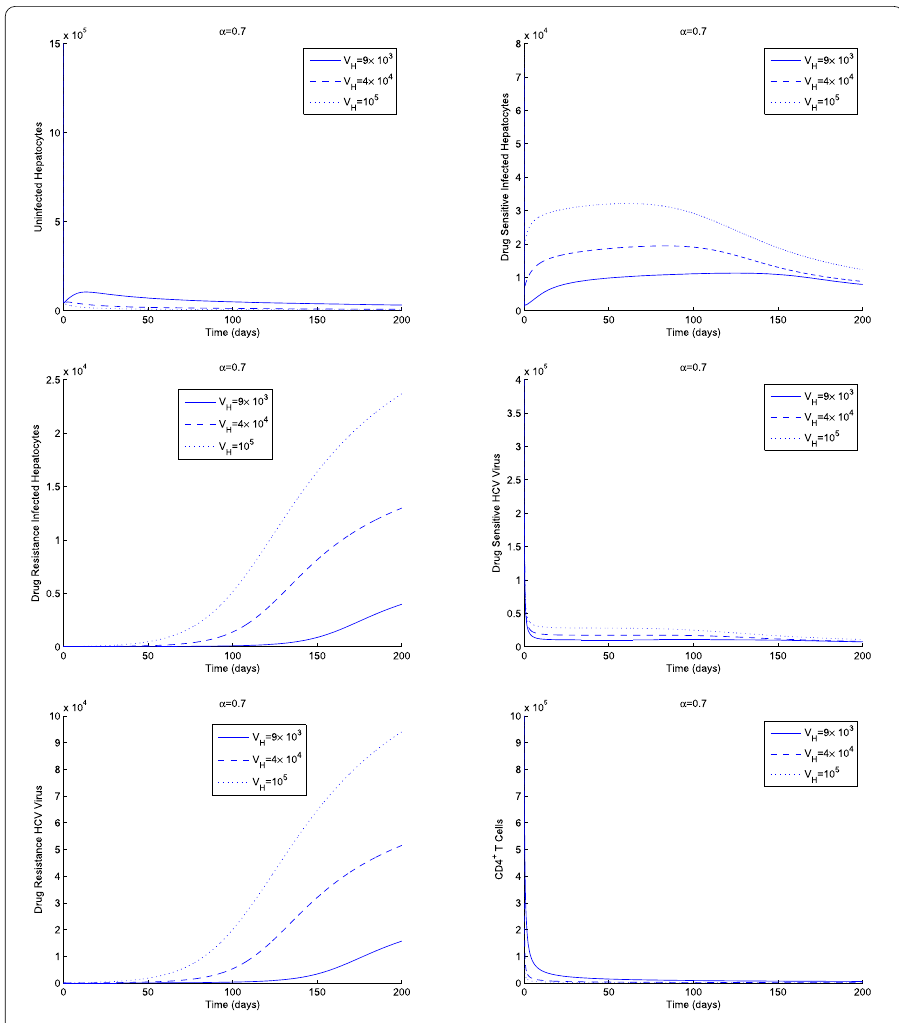
Figure 4 Dynamics of the variables of system (1) for different values of V H , the HIV viral load, and α = 0.7. Parameter values are in Table 1 and initial conditions are in the text.